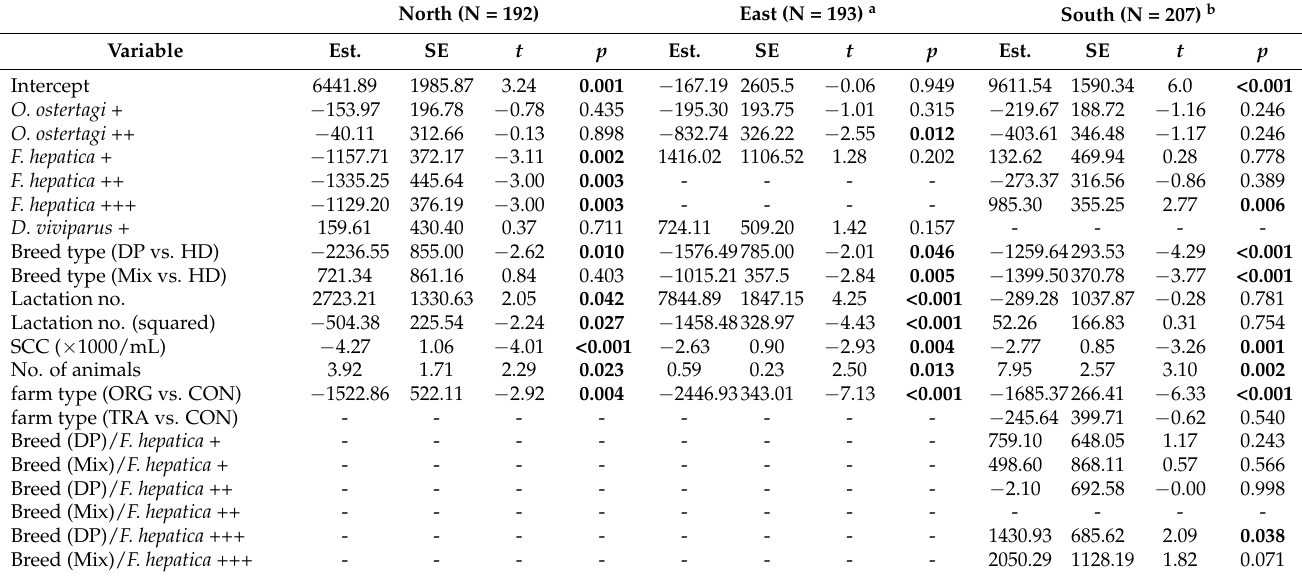
Table 6. Results from linear models investigating the association of O. ostertagi , F. hepatica and D. viviparus BTM ELISA results and average annual milk yield per cow (kg) in three regions of Germany. Full models were significantly different from null models containing only an intercept term (North: Df = 13, F = 8.5, p < 0.001; East: Df = 11, F = 20.1, p < 0.001; South: Df = 18, F = 8.8, p < 0.001). Significant p -values are printed in bold. Seropositivity categories are defined as